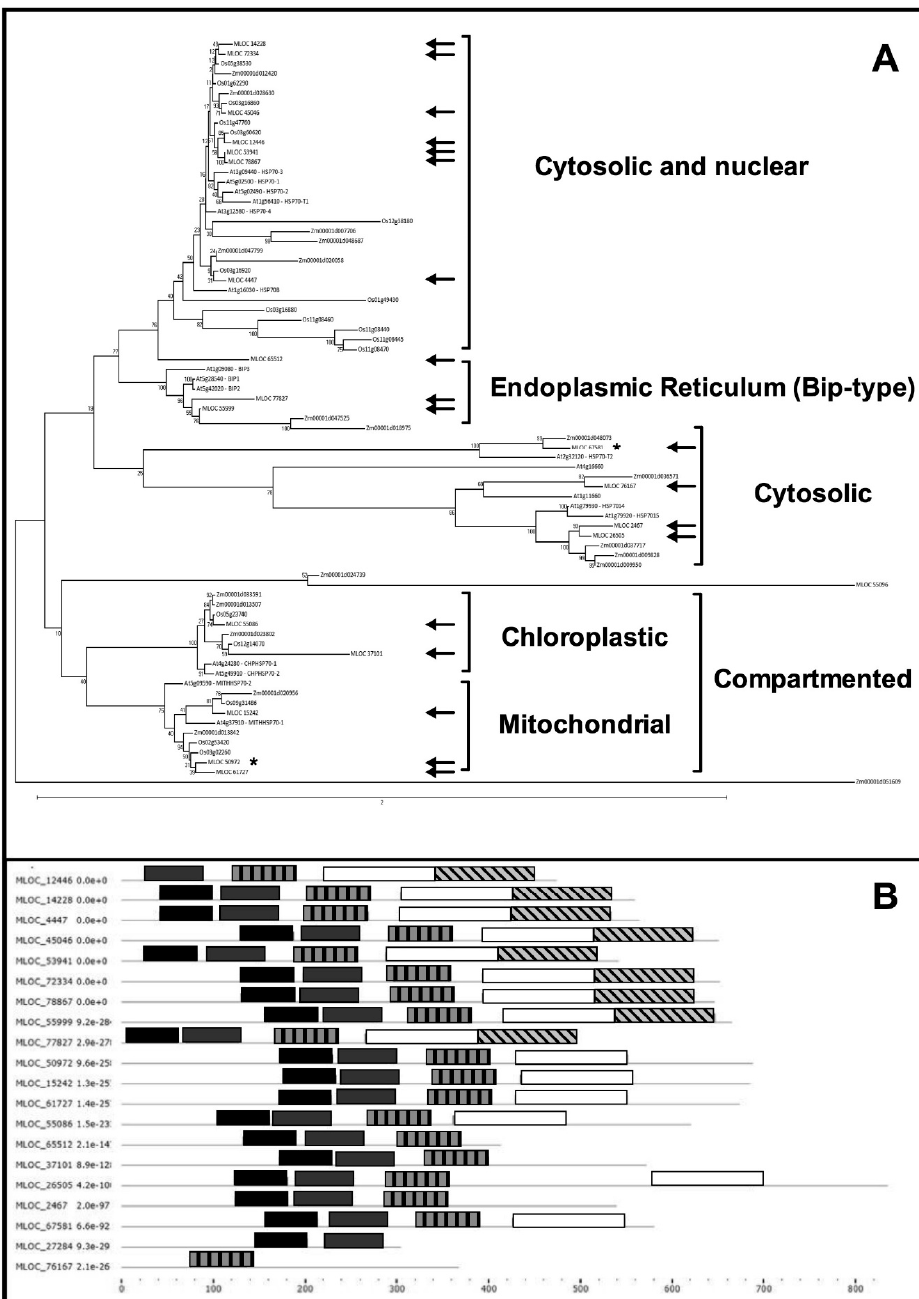
Figure 3. ( A ) A phylogenetic tree obtained by comparison of barley HSP70 amino acidic sequences of translated genes performed versus the correspondent Arabidopsis thaliana , Oryza sativa and Zea mays sequences. The predicted subcellular localizations are indicated for the four main branches; the arrows indicate the position of barley HSP70 isoforms. The asterisks indicate the two barley isoforms utilized for further expression studies. See text for further details. ( B ) Conserved domain analysis of barley HSP70 proteins, obtained using the MEME bioinformatic tools (http://meme-suite.org). The di ff erent color boxes represent di ff erent types of domains: ATPase binding domains (black, grey and vertical line pattern), substrate binding domain (white block) and the c-term lid (crossing line pattern). The number indicated the position of amino acids in protein